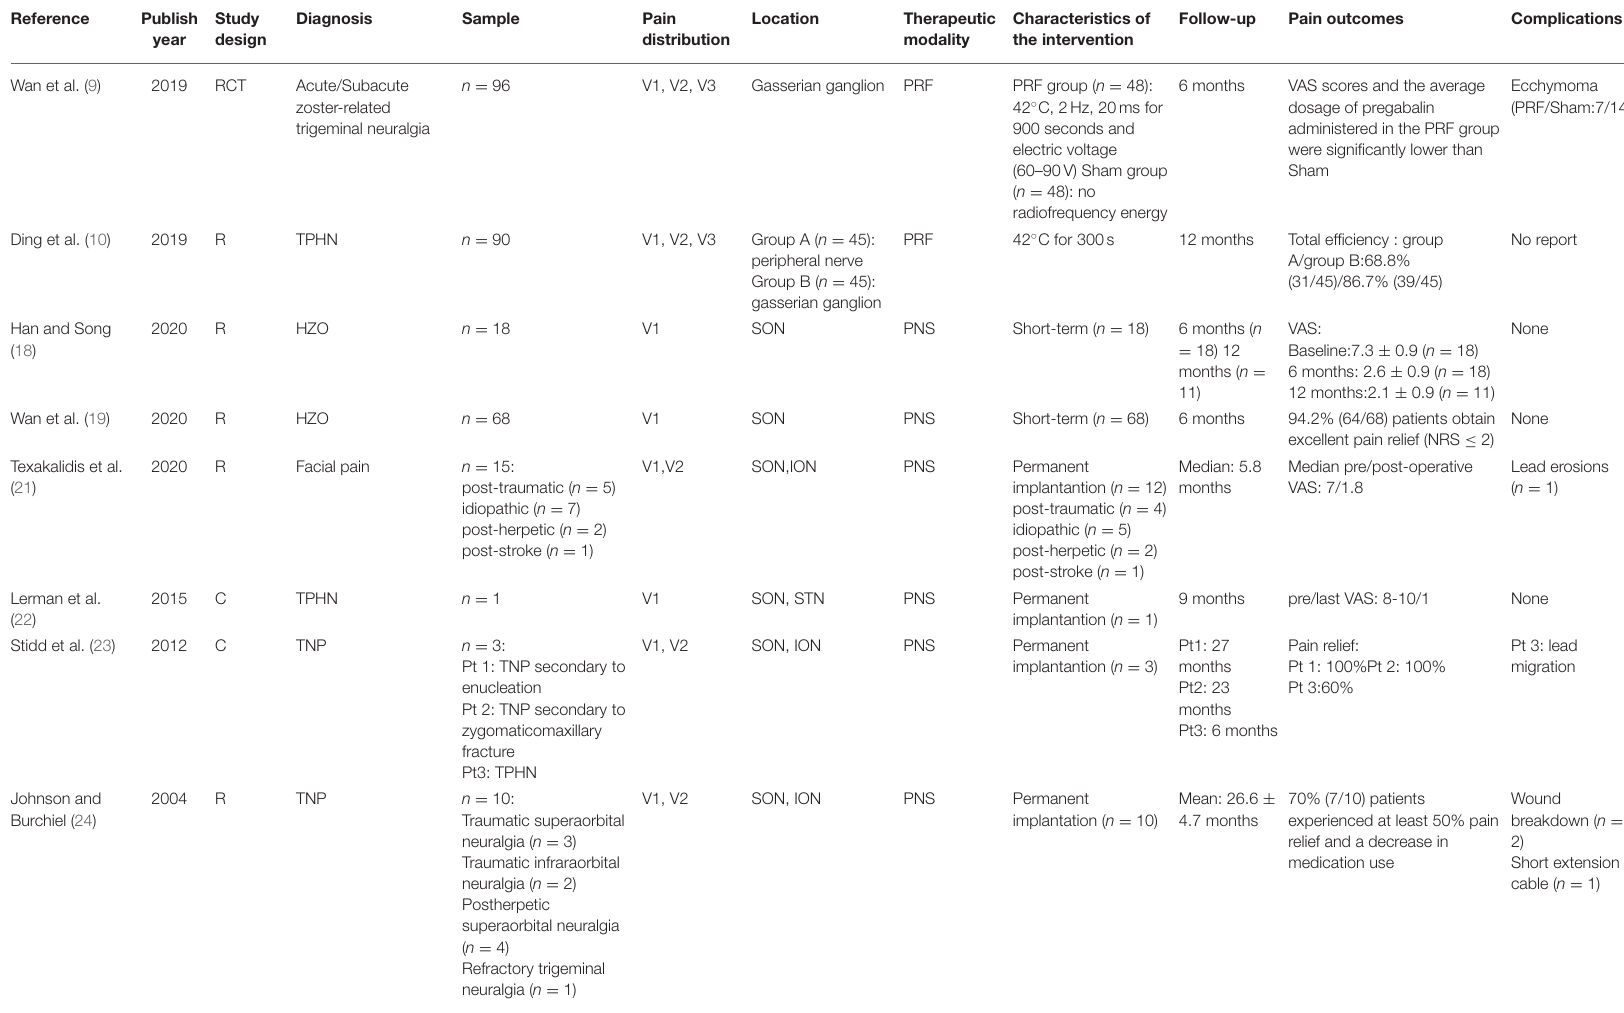
TABLE 1 | Characteristics and results of studies that have assessed the use of pulsed radiofrequency, peripheral nerve stimulation, and high cervical spinal cord stimulation to treat HZ-related and other types of facial pain.